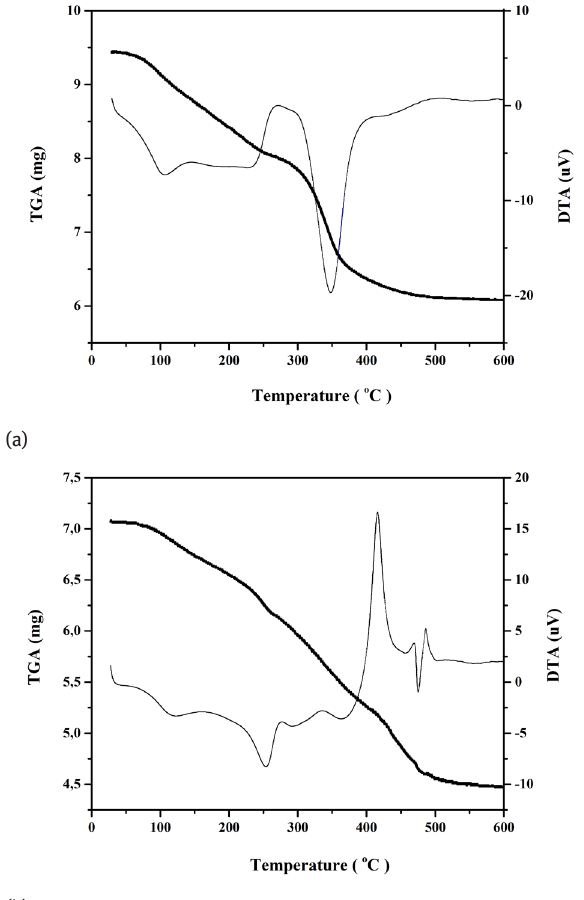
Figure 2: FTIR spectrum of Ni-Al-NO Benzoate after ion exchange with amoxicillin (c); and amoxicillin (d).